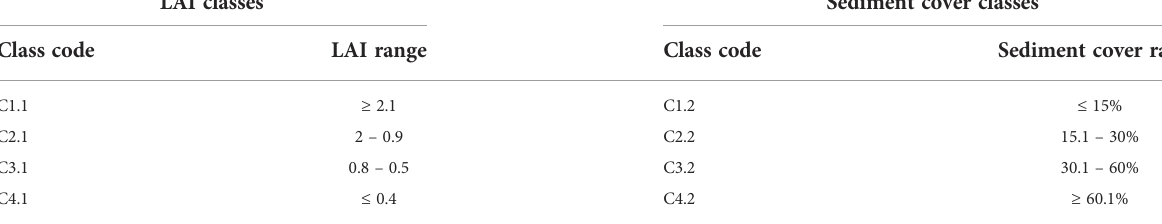
TABLE 1 Value range of LAI and sediment cover to de fi ne the classes.